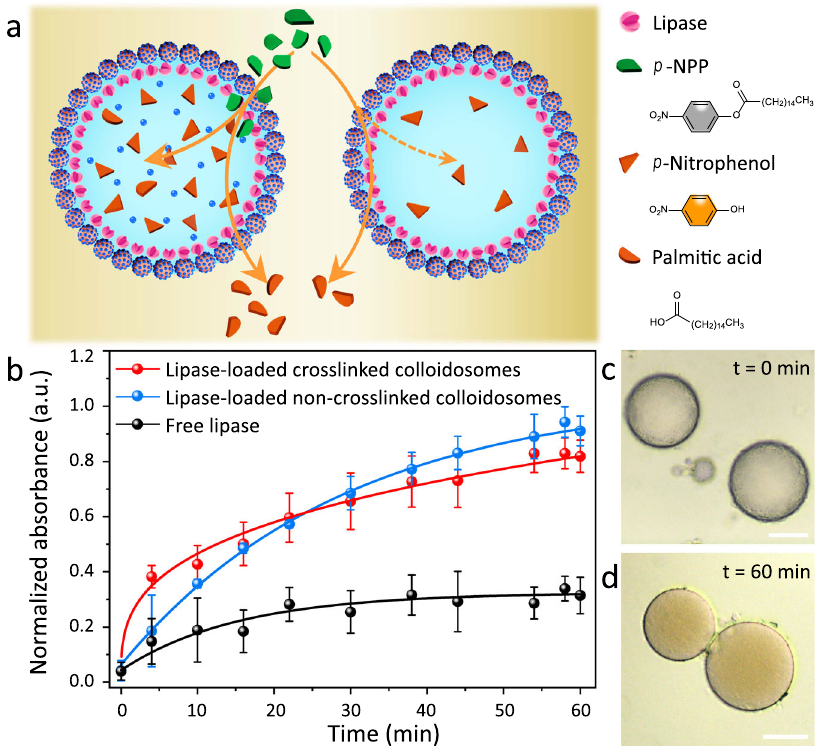
Fig. 3 A colloidosome-based microreactor for lipase-catalyzed hydrolysis reactions. a Comparison of lipase-catalyzed hydrolysis within the lipase-loaded colloidosomes with and without TMOS crosslinking. b Kinetics of p -NPP hydrolysis into p -nitrophenol catalyzed by lipase-loaded crosslinked colloidosomes (red plot), lipase-loaded non-crosslinked colloidosomes (blue plot), and free lipase (black plot). The loaded lipase for all groups was 0.005 mg. Error bars indicate the SD of three replicating measurements. c , d Optical microscopy images of the lipase-loaded crosslinked colloidosomes before ( c ) and after ( d ) p -NPP hydrolysis, showing the generation of yellow p -nitrophenol over time inside the aqueous lumen. Scale bars: 20 μ